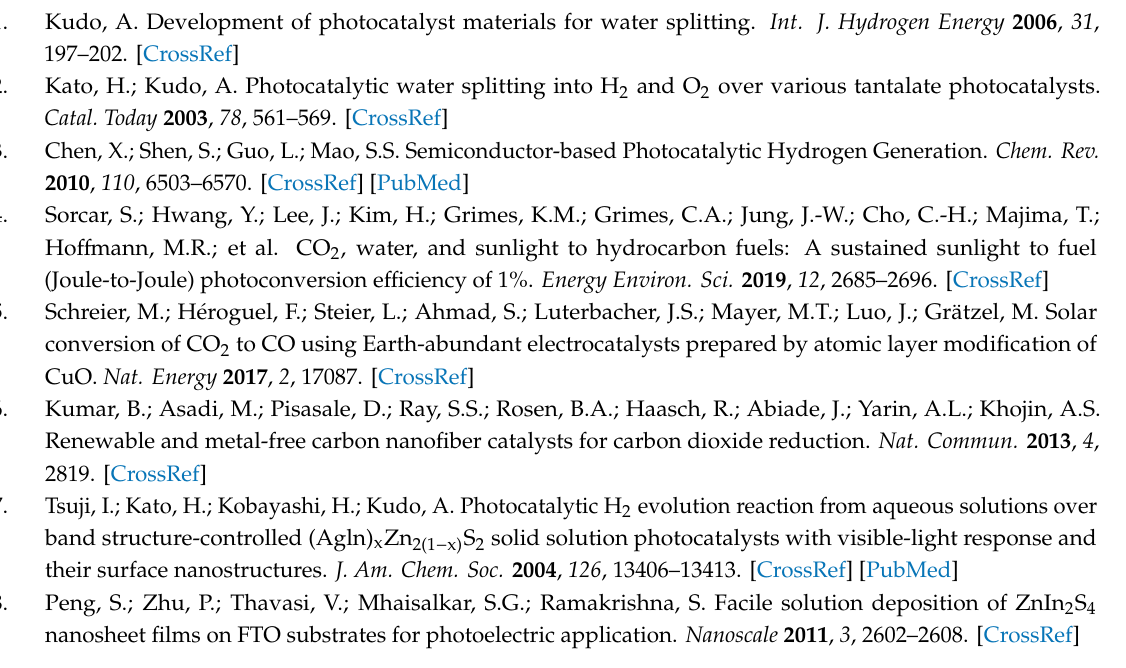
Table S1: Starting material for the preparation of photocatalyst; Table S2: Expected composite components of photocatalyst (molar ratio); Table S3: Elemental ratios of Zn (1 − 2x) (CuGa) x In 2 S 4 from XPS result; Table S4: Surface area of photocatalysts; Figure S1: XPS survey spectra of Zn (1 − 2x) (CuGa) x In 2 S 4 ; Figure S2: Adsorption / desorption IsothermofZn (1 − 2x) (CuGa) x In 2 S 4 ; FigureS3: TaucplotsofZn (1 − 2x) (CuGa) x In 2 S 4 ; FigureS4: Valence-bandedgeXPS spectra of (a)